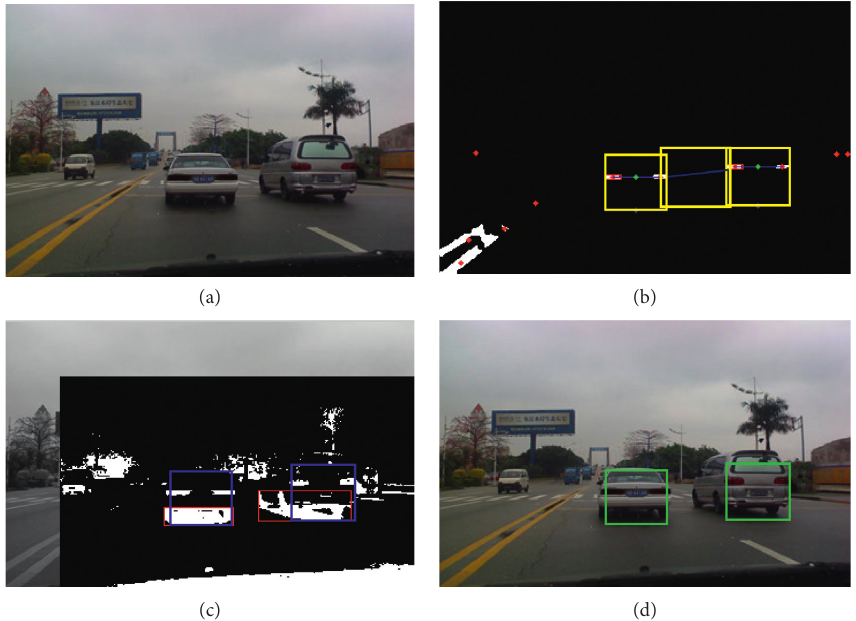
Figure 13: Detection results of two parallel vehicles based on the composite feature in cloudy day environment. (a) The original image. (b) Taillight extract result. (c) Shadow extraction results. (d) Vehicle detection and marking